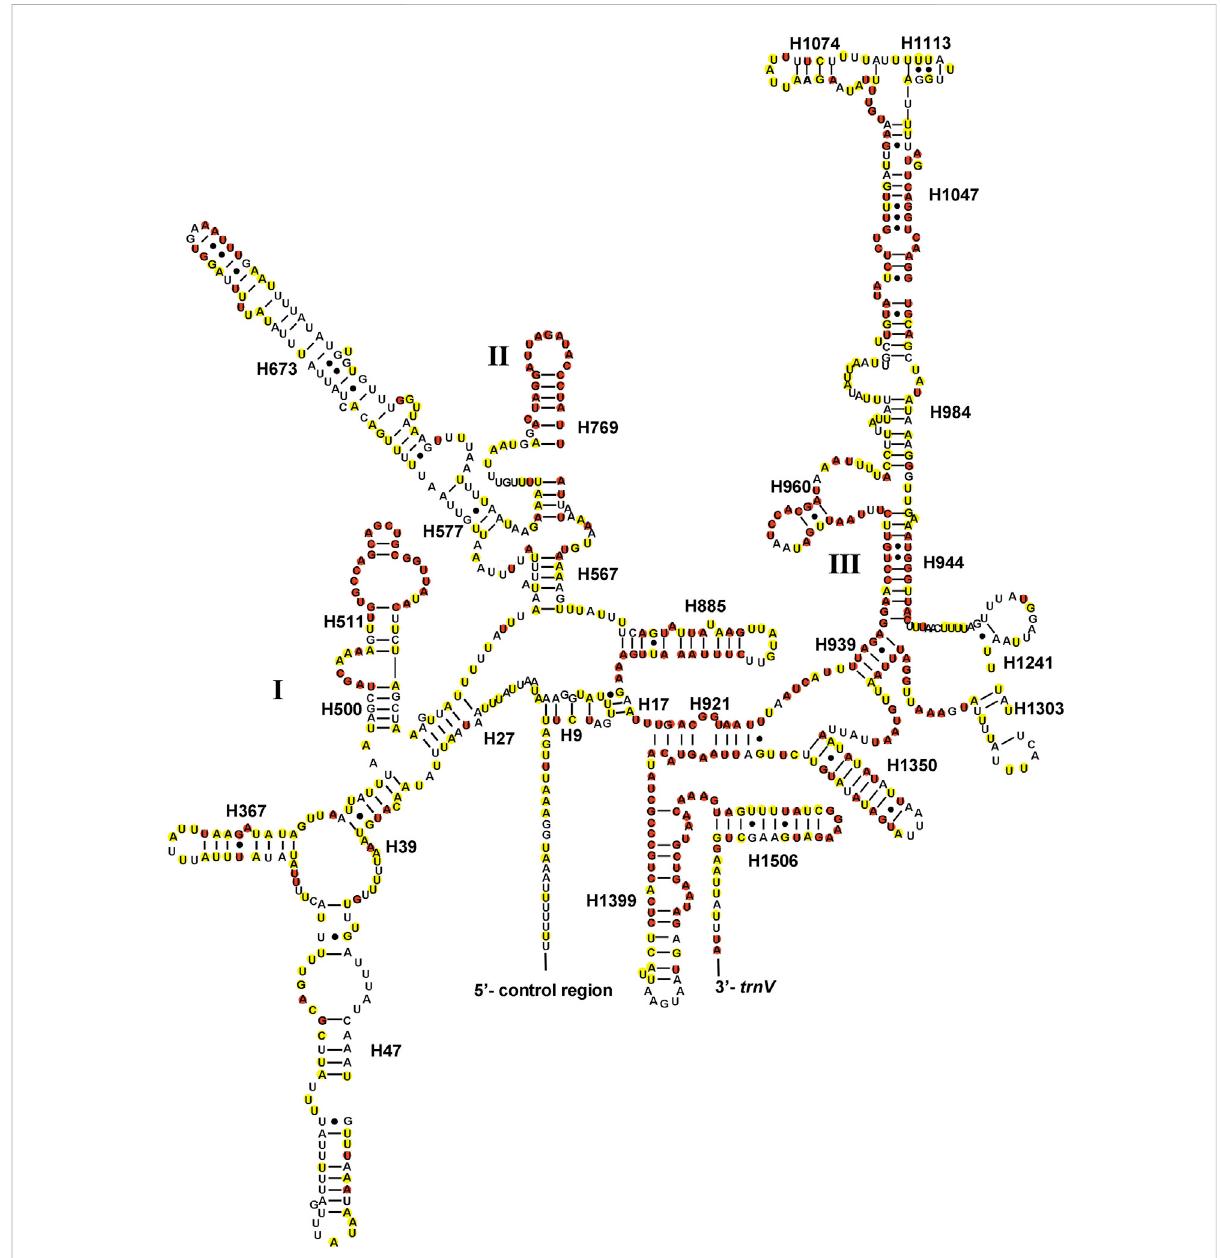
FIGURE 5 The potential secondary structure of the 12S rRNA in Gonopsis coccinea . Conserved sites are marked red in Pentatomidae and yellow in